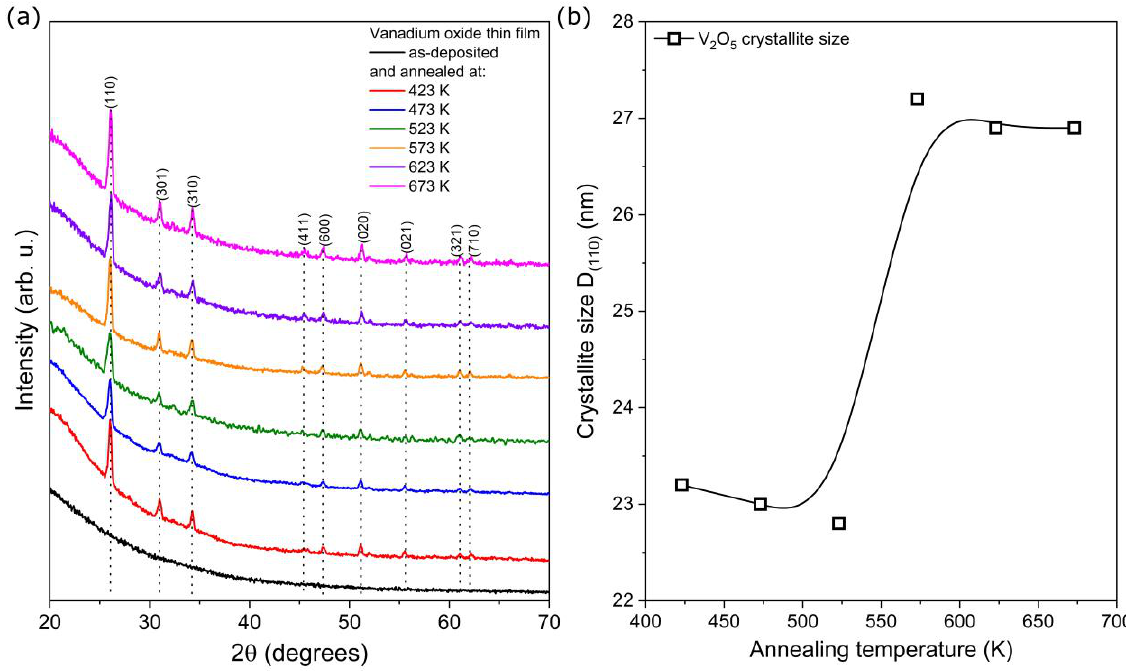
Figure 1. X-ray diffraction measurements results: ( a ) diffraction patterns and ( b ) an average crystallite size of V 2 O 5 thin films annealed at various temperatures calculated for (110) crystal plane.